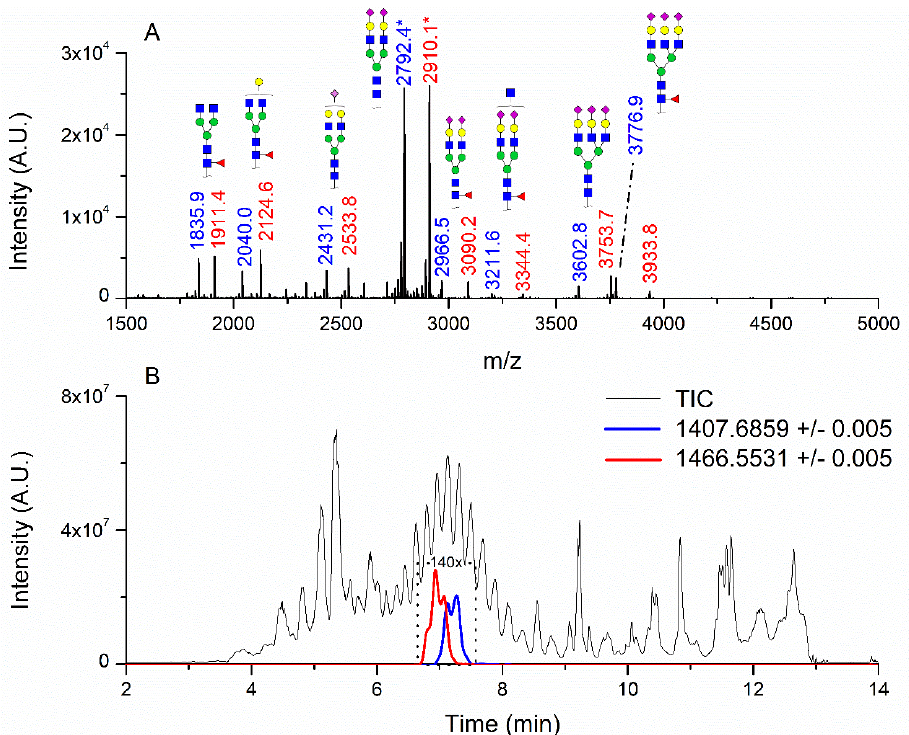
Figure 1. Analysis of serum N-glycans by mass spectrometry. ( A ) MALDI-TOF/MS spectrum of blood serum N-glycans of patient 7 mixed with those from the control pool in positive mode in the range m / z 1500–5000. Ions whose masses correspond to methylated N-glycans are depicted in blue, while those from deuterated structures are given in red. The two most intense peaks correspond to the N-glycan HexNAc4Hex5NeuAc2 in its permethylated form ([M + Na] + = 2792.4 Da), obtained from patient 7, and deuterated forms ([M + Na] + = 2910.1 Da), obtained from control pool. Proposed structures were drawn for their corresponding N-glycan compositions and are depicted on top of their corresponding ions. ( B ) LC-MS analysis showing total ion chromatogram (black line) and extracted ion chromatograms for the N-glycan HexNAc4Hex5NeuAc2 in the permethylated form ([M + Na] 2+ = 1407.6859 Da) isolated from patient 7 and deuterated form ([M + Na] 2+ = 1466.5531 Da) obtained from control pool. Masses and XICs in blue and red indicate light (methylated) and heavy (deuterated) derivatized N-glycans, respectively. The asterisks drawn in inset A correspond to the same N-glycans analyzed in inset B, although the latter in a different charge state than the former.